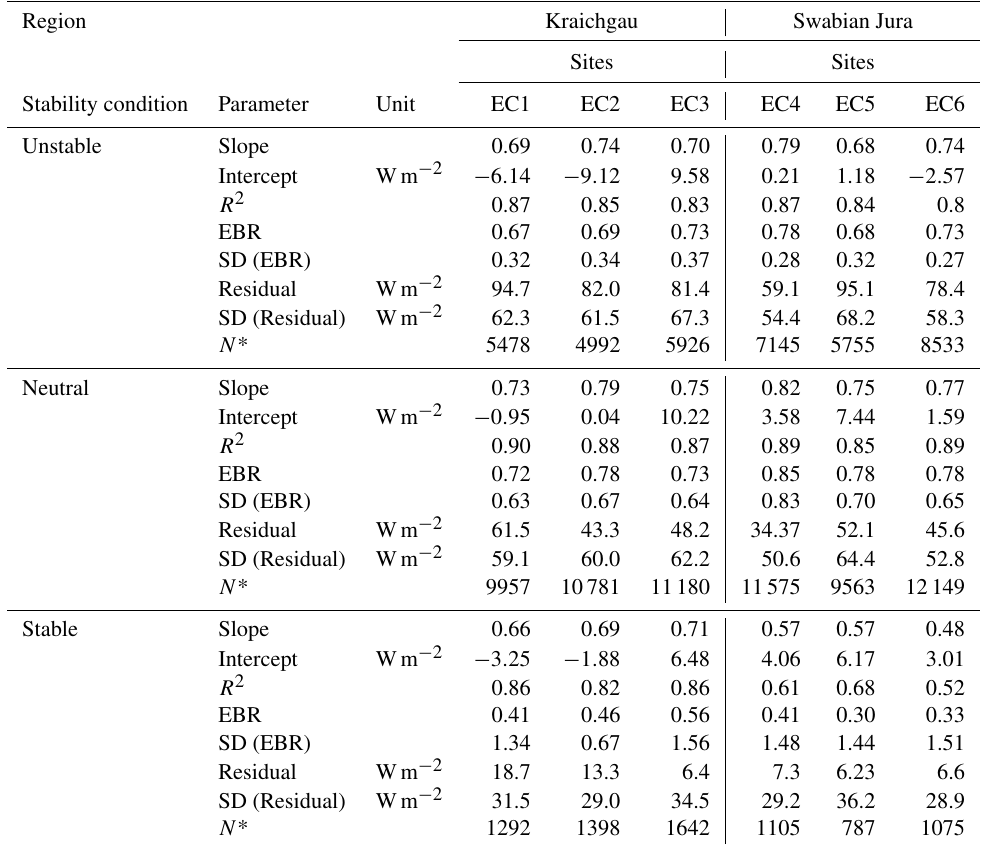
Table 4. Energy balance closure (EBC) as indicated by the slope of linear regression of turbulent vs. available energy and energy balance ratio (EBR) under different atmospheric stability conditions. EBC and EBR are given as site-specific averages from 2010 to 2017. SD is standard